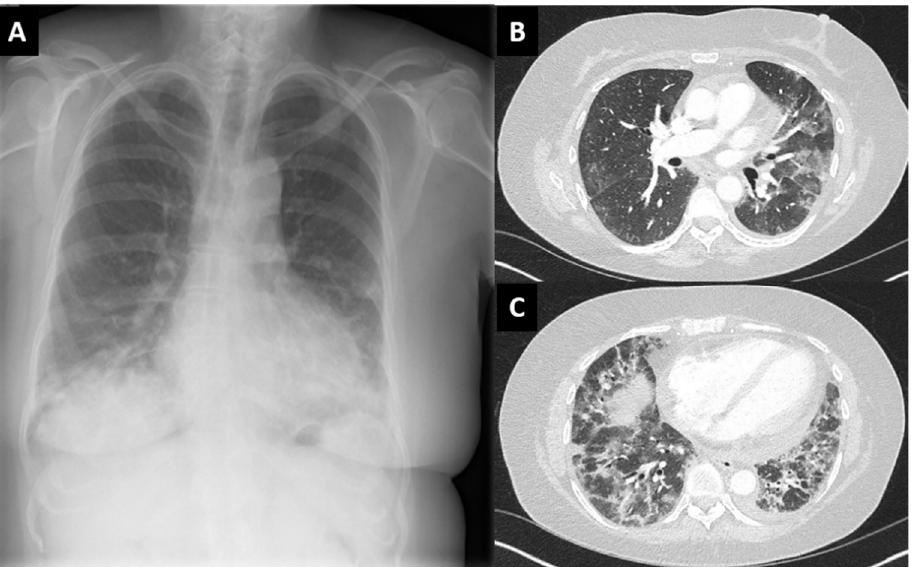
Figure 2. Chest X-ray ( A ) and high-resolution computed tomography scan ( B , C ) of case 3 (female, 58 years old) with findings compatible with interstitial lung disease. Lung biopsy not performed. Anti-nuclear autoantibodies (ANA) were positive in 8 cases and negative in 7 cases.